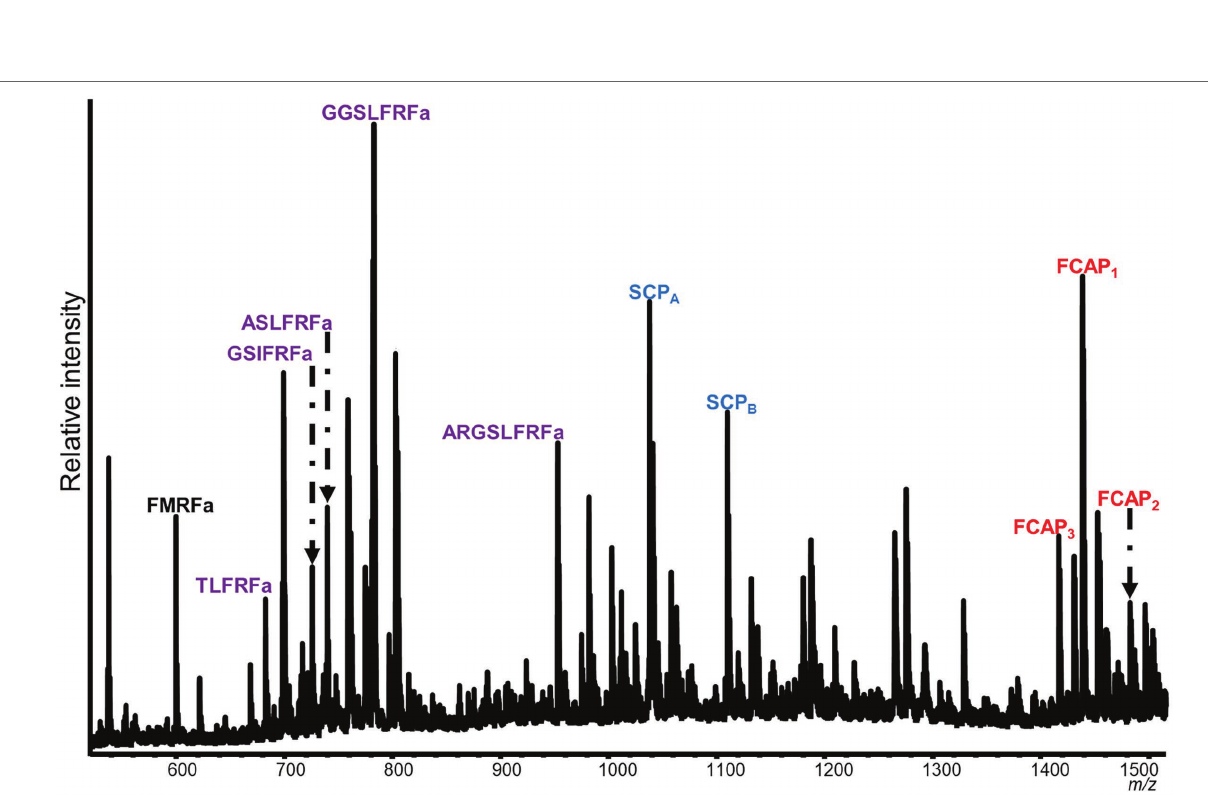
FIGURE 2 | Representative spectrum from a H. crassicornis SLB cell. Six neurons were analyzed, and peptides from the FMRFa (black), SCP B (blue), LFRFa (purple), and FCAP (red) prohormones were present. The LFRF prohormone is predicted to produce five peptides with a C-terminal LFRFa motif, the FCAP prohormone, three versions of the FCAP peptide, and the SCP prohormone, both SCP A and SCP B ; all of these were present in the cell. The FMRFa prohormone is predicted to produce multiple tetrapeptides, but only FMRFa was present in the cell.